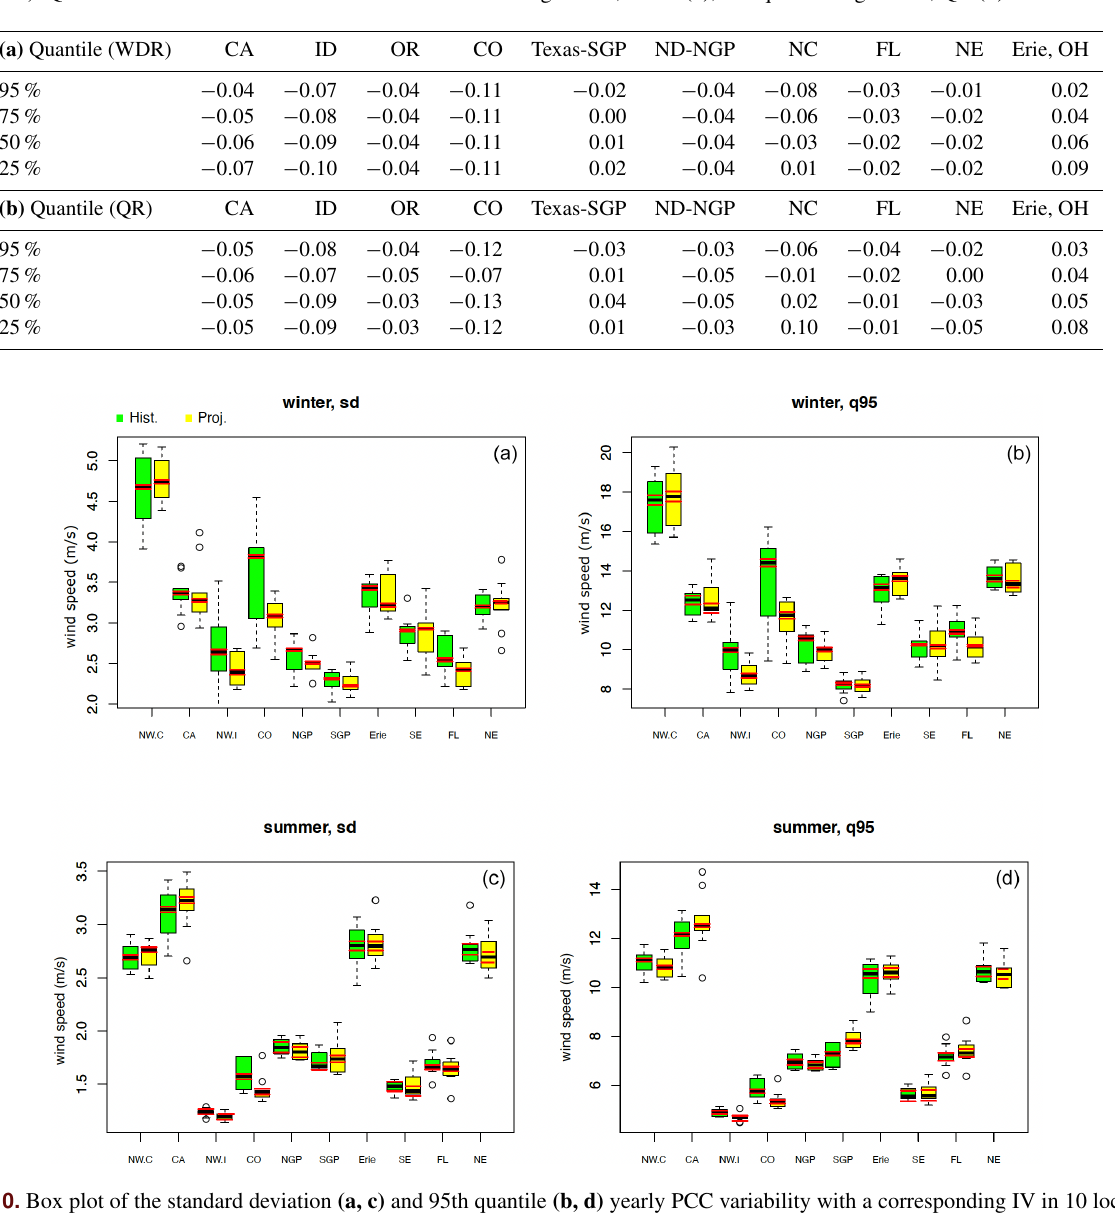
choices can be found in Murphy et al. (2022). Second,